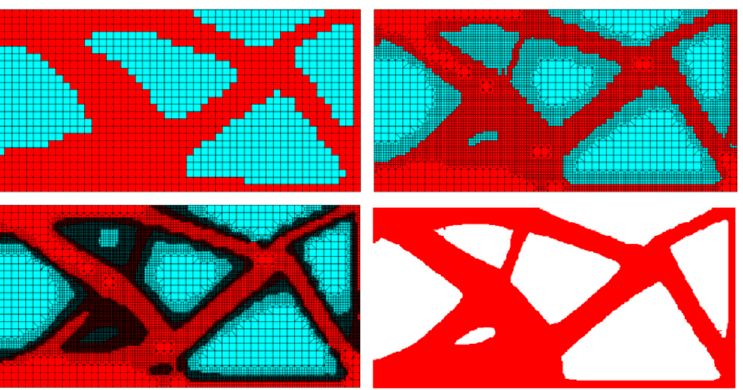
Figure 18. Selected middle topologies and the final one for the cantilever structure. For the last iteration the grid has not been shown to improve the clarity of the picture.